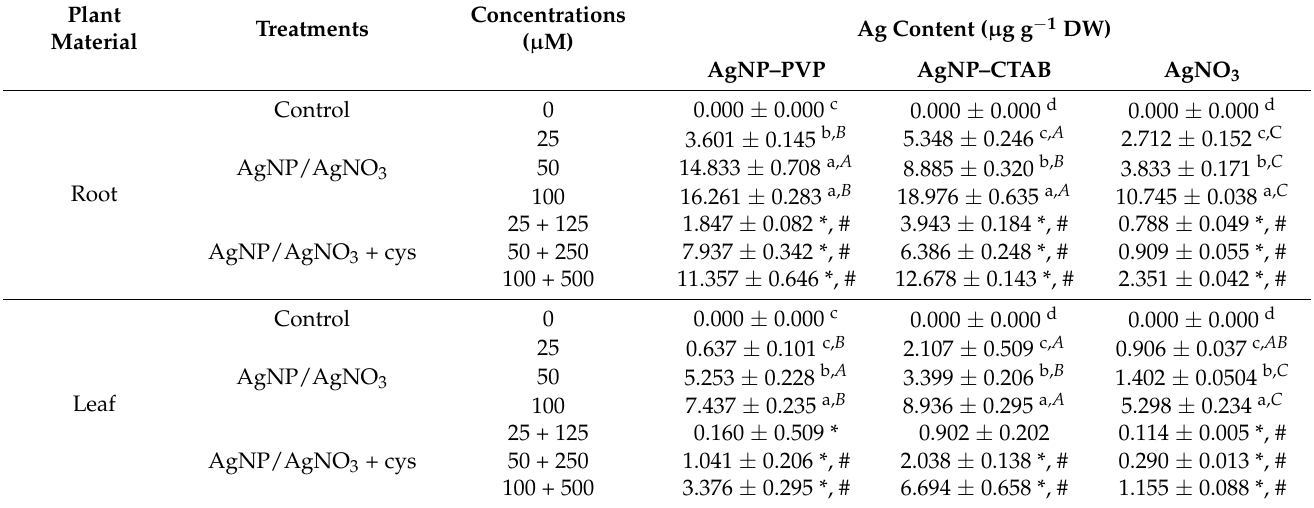
Table 1. Ag content in roots and leaves after 7 days of tobacco plants exposure to 25, 50, and 100 µ M AgNP–PVP, AgNP–CTAB, and AgNO 3 , applied either alone or in combination with 125, 250, and 500 µ M cysteine (cys),